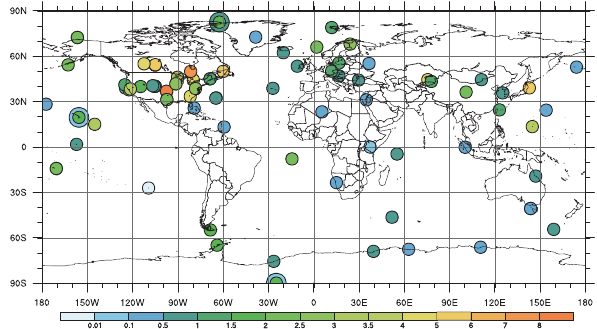
Figure 9. Average normalized information content for each obser- vation site from 2001 to 2009. The overlapping observation sites at the same locations or at close locations are distinguished using different sizes of